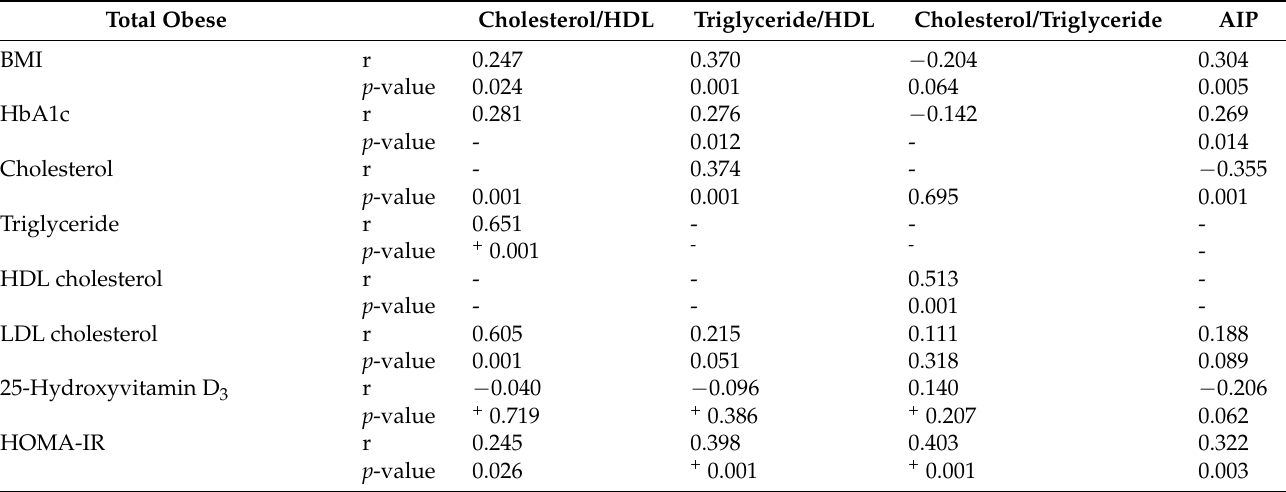
Table 3. Correlations in the total obese adolescent group